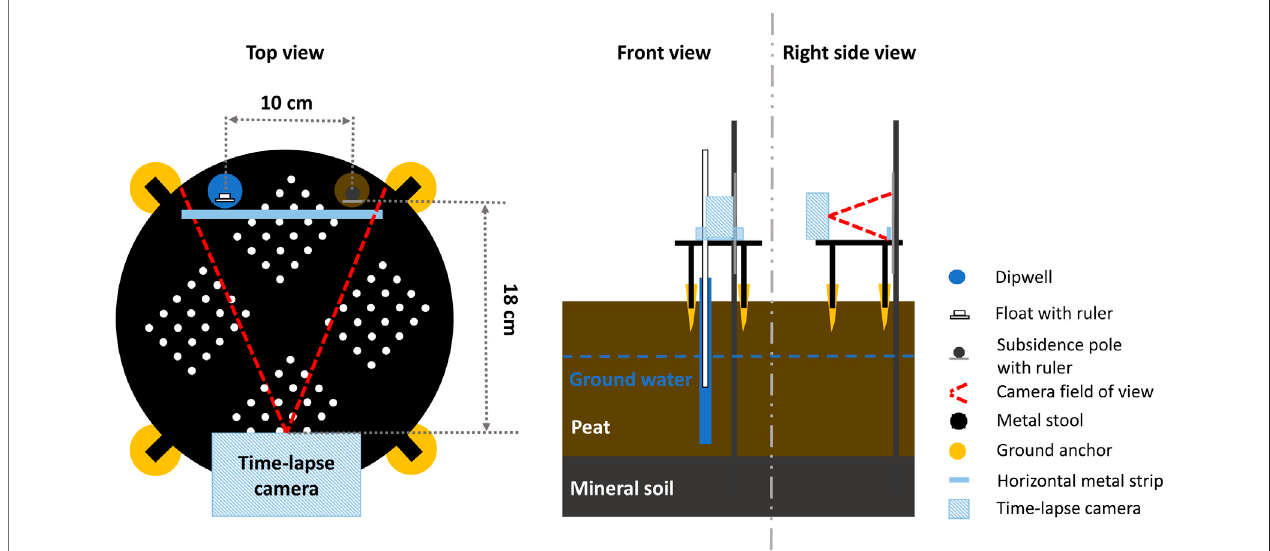
FIGURE 1 | Schematic of peat cameras